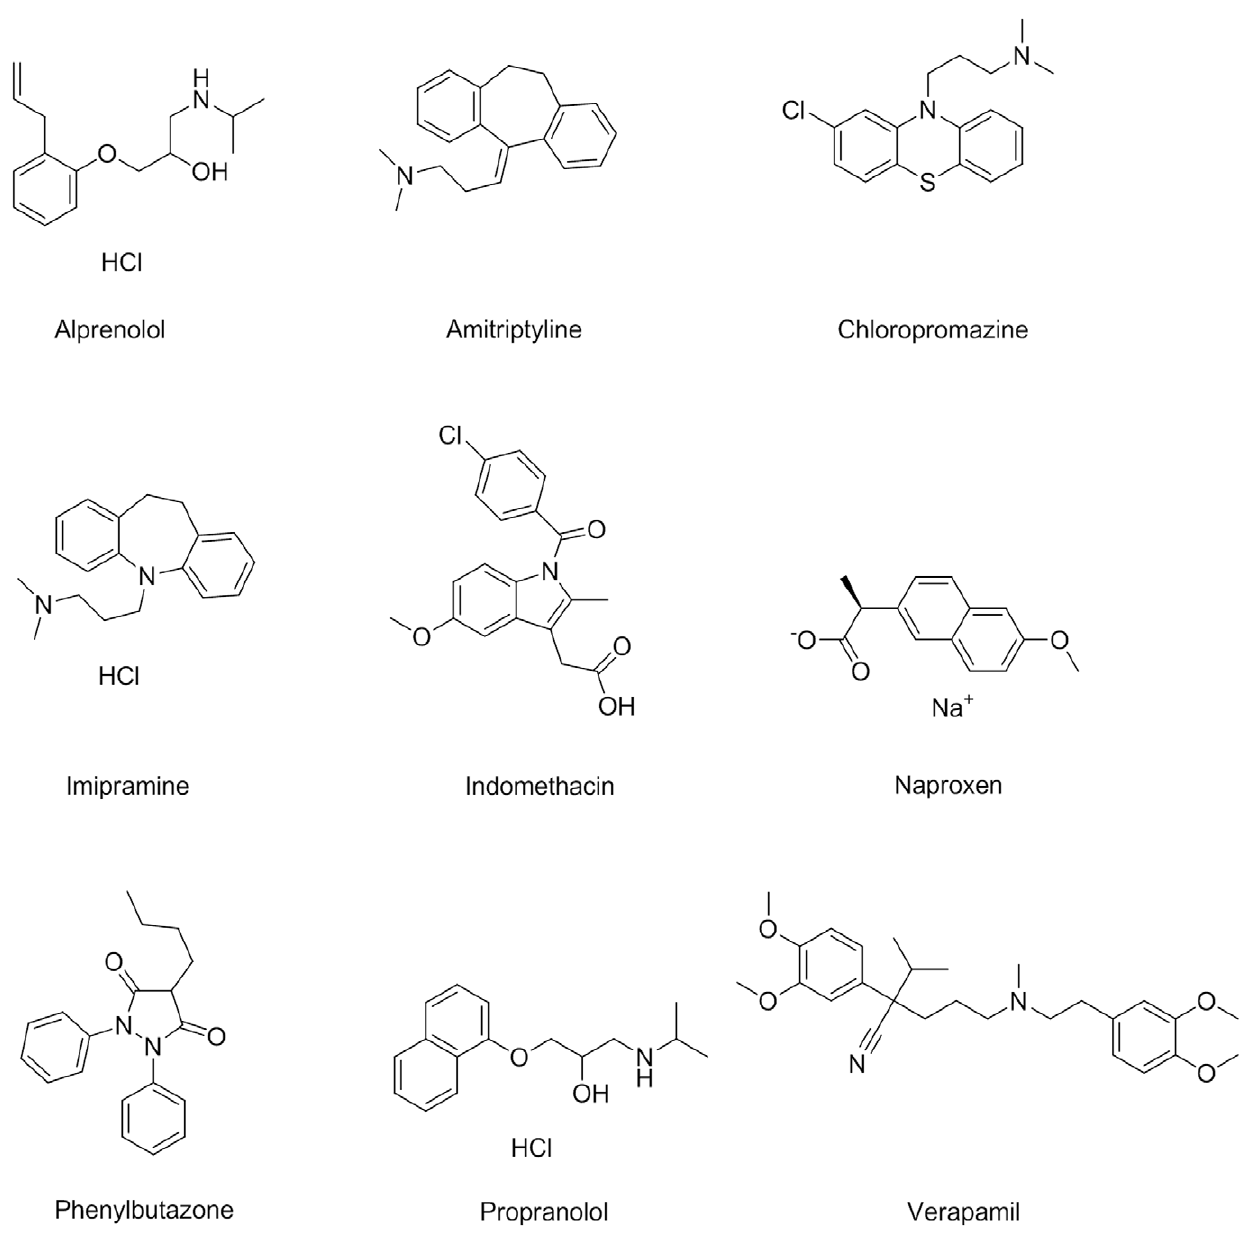
Figure 5. Structures of the AGP and HSA Validation Set.